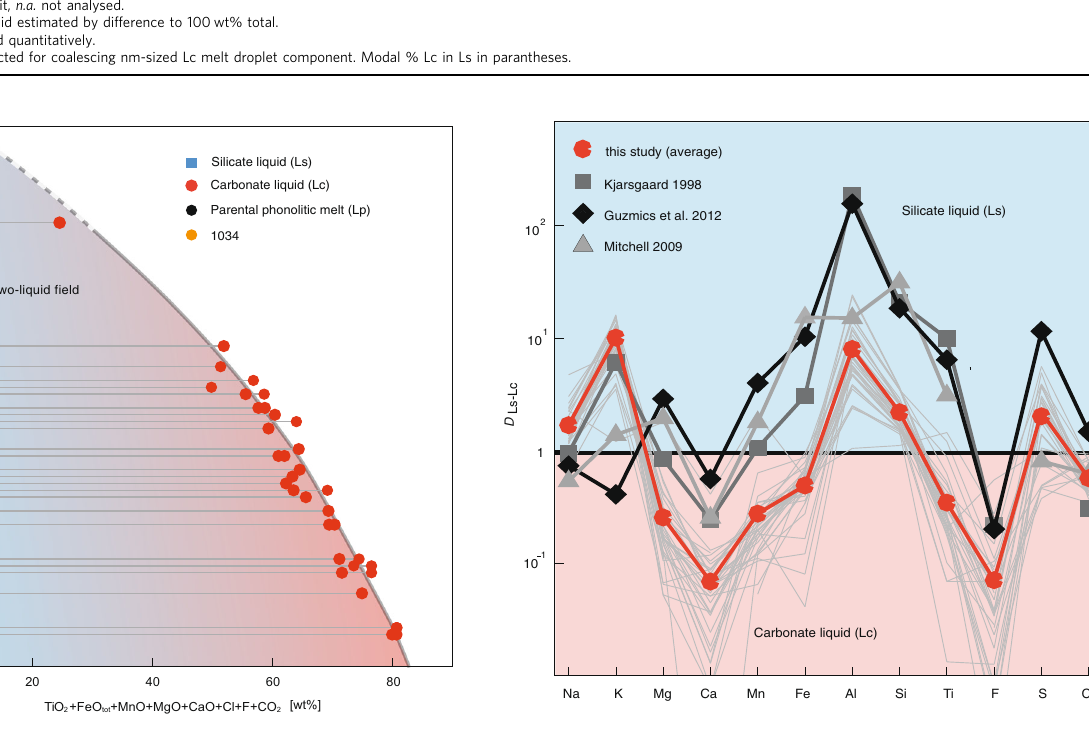
Fig. 3 Compositions of conjugate immiscible carbonate and silicate melt. Conjugate immiscible carbonate and silicate melt compositions plotted as a function of the partition coef fi cient of SiO 2 between carbonate and silicate melt ( D SiO ) showing the compositional gap between the two melts. 2 Calculated parental phonolitic melt (Lp) is given in Table 1. LST layer 1034 bulk rock composition is taken from 40 .